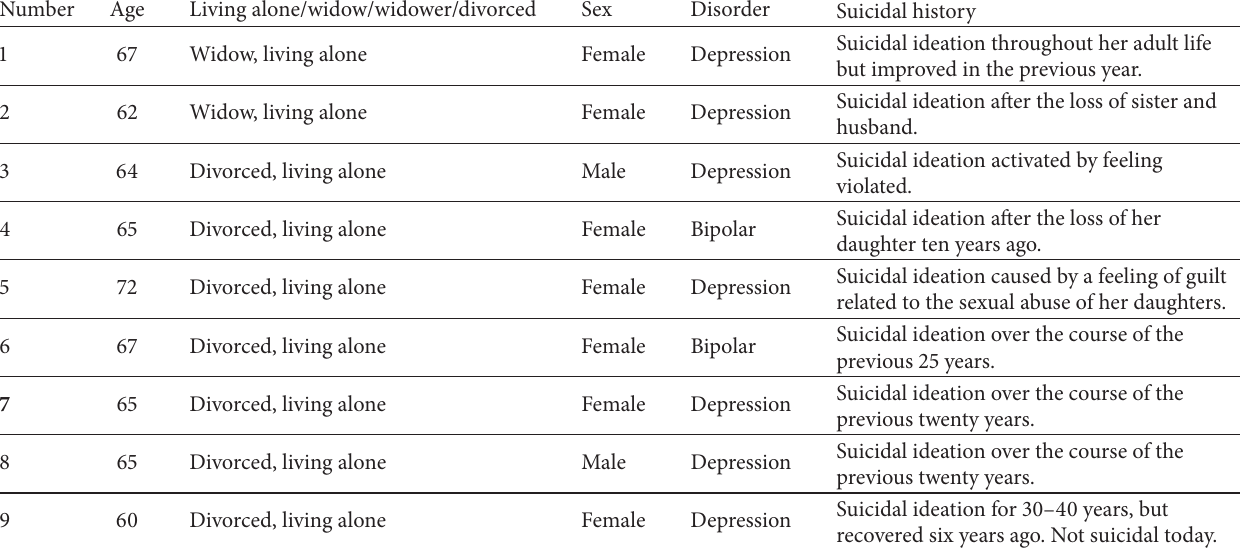
Table 2: Demographic characteristics and suicidal